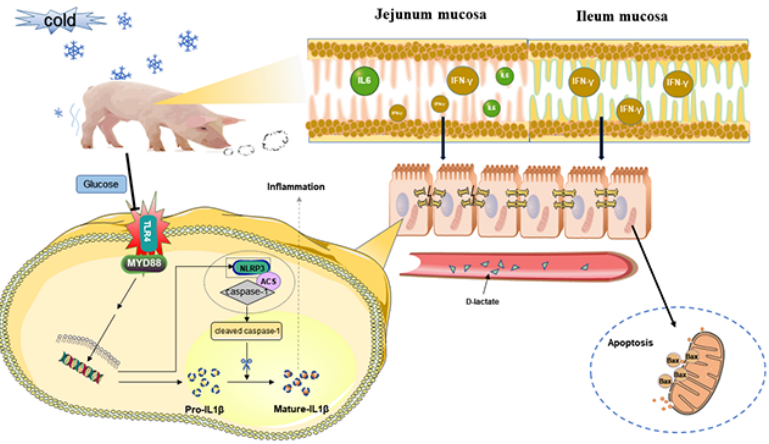
Figure 8. Cold stress induced small intestinal mucosal injury via TLR4/MyD88 signaling, and glu- cose supplementation alleviated small intestinal mucosal